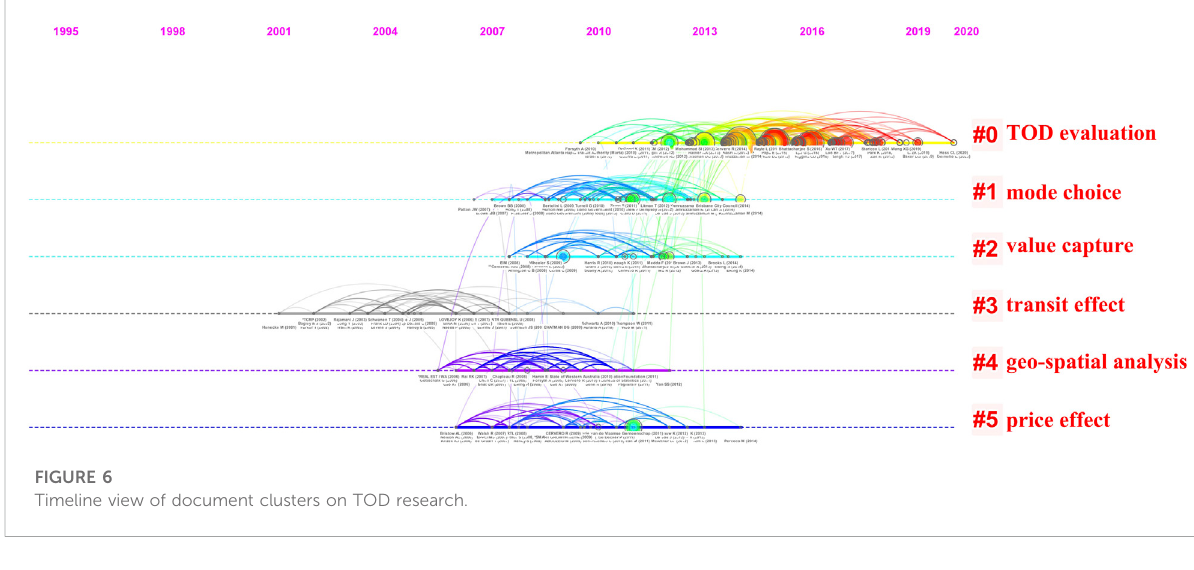
FIGURE 6 Timeline view of document clusters on TOD research.